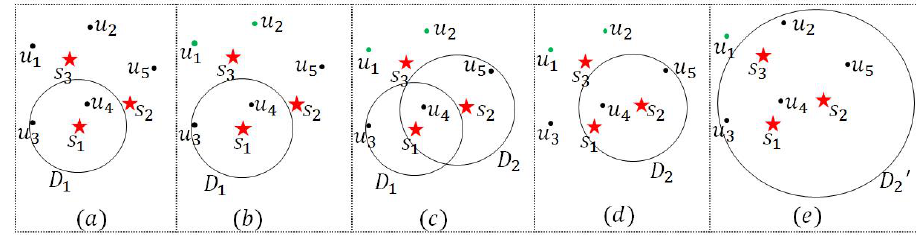
Figure 1. A simple example U = { u 1 , u 2 , u 3 , u 4 , u 5 } , S = { s 1 , s 2 , s 3 } and t =